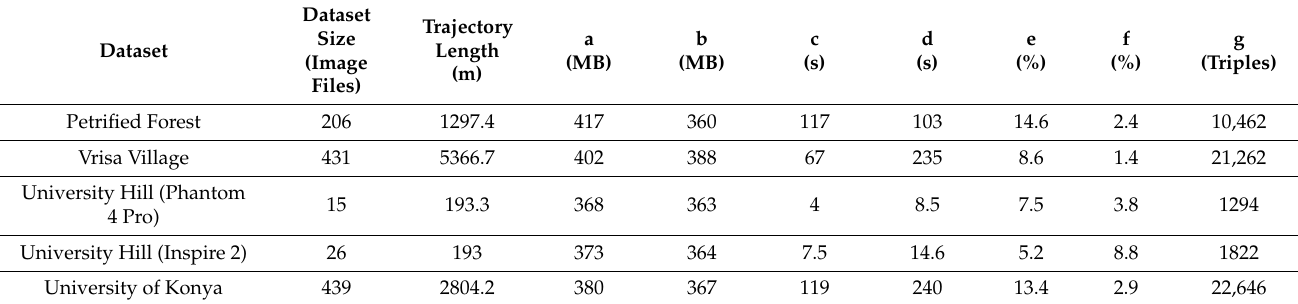
Table 2. Experimental results of ReconTraj4Drones